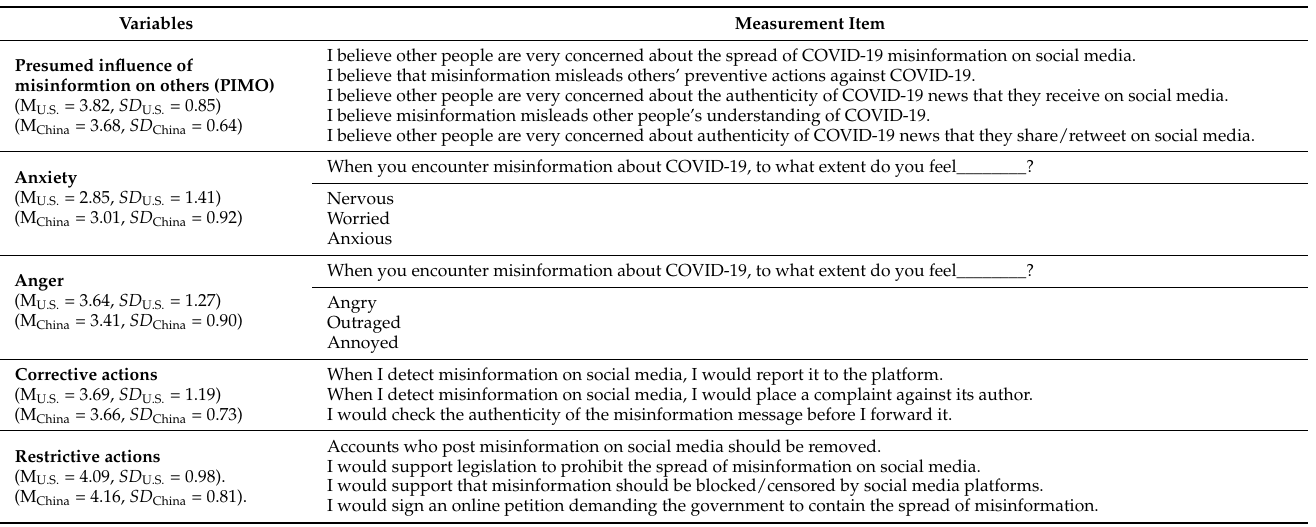
Table A1. Survey Questions and Descriptive Data in